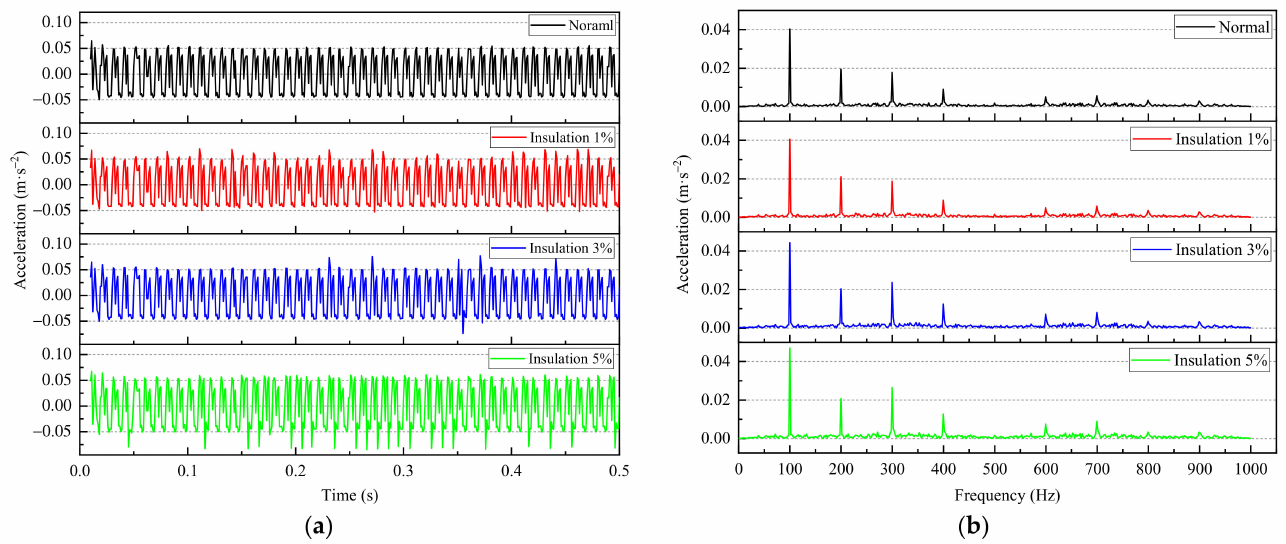
Figure 11. Acceleration signal under normal and different inter-turn short circuit faults at wind- ing surface point 1. ( a ) Acceleration time domain signal under normal and insulation conditions; ( b ) frequency domain signal of acceleration under normal and insulation